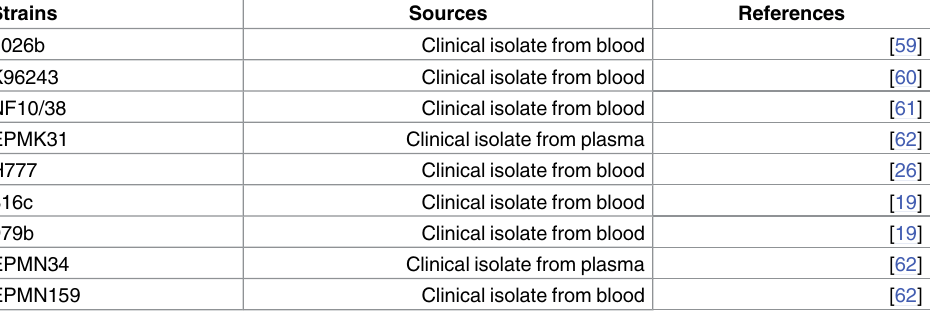
Table 1. Strains of B . pseudomallei used in this study.